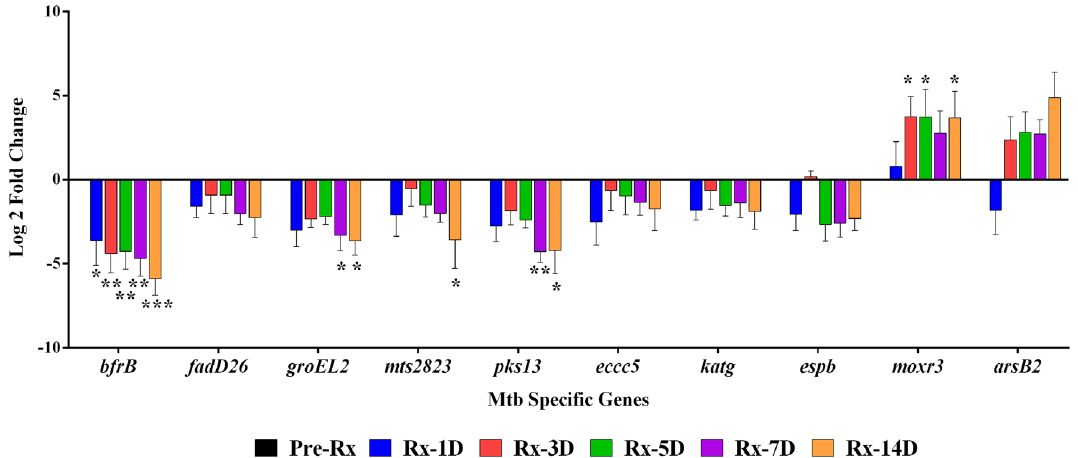
Figure 4. Validation of the ten differentially expressed genes in ten patient sets by qRT-PCR. The graph shows the change in Mtb-specific genes’ expression during different treatment days in 10 patient samples relative to pretreatment. The data were normalized using 16S as housekeeping, and relative gene expression was calculated by the ΔΔCt with pretreatment (Pre-Rx) as control. Asterisks indicate a significant difference in gene expression between days of treatment compared to pretreatment, with p < 0.05 considered statically significant. Average log2 fold change values are plotted; the error bars mark standard deviation. * p < 0.05, ** p < 0.01, *** p <